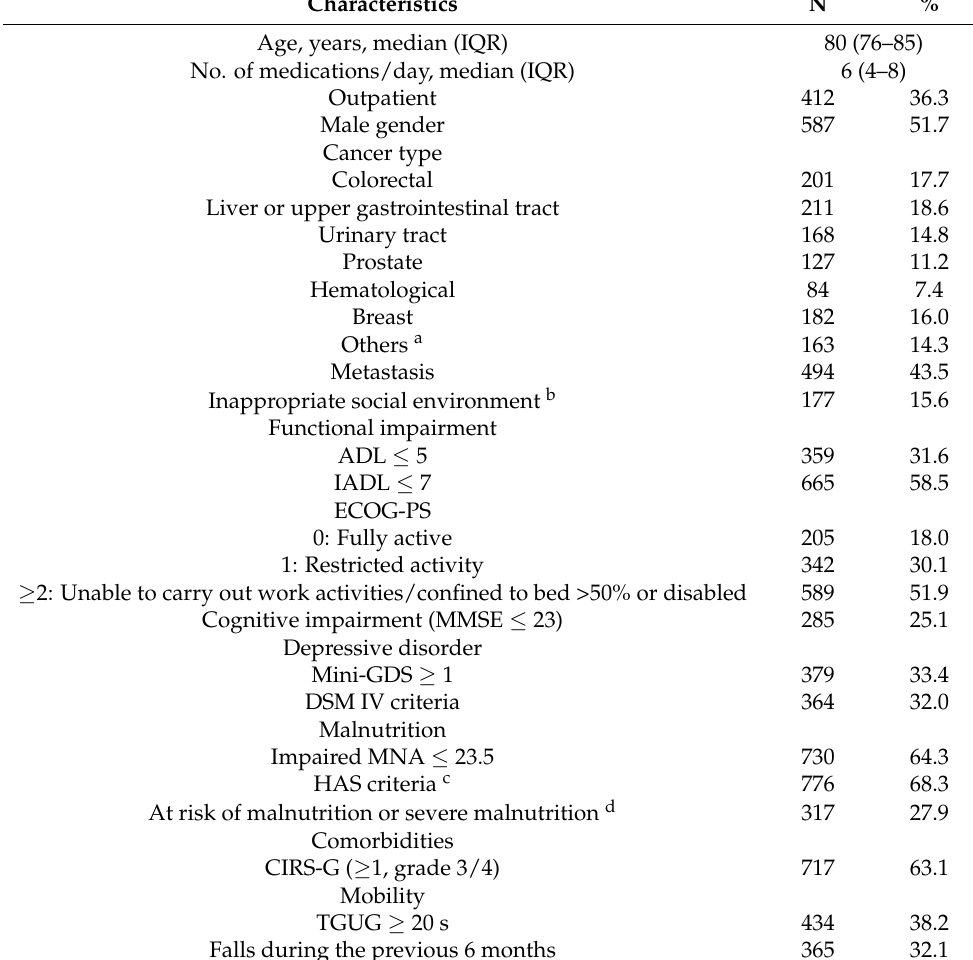
Table 1. Patient baseline characteristics (N =